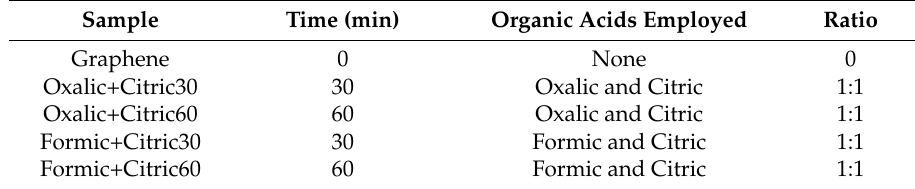
Table 1. Identification of the samples according to the treatment time. Sample Time (min) Organic Acids Employed Ratio Graphene